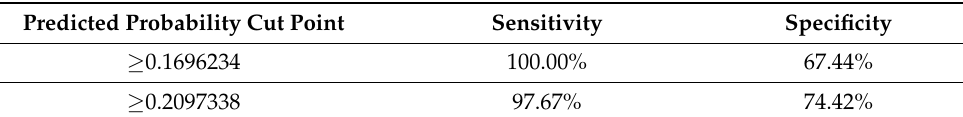
Table 4. Immuno-oncology panel: sensitivity/specificity plot for the resulting multivariate logistic regression model, and for sensitivity levels higher than specificity levels.